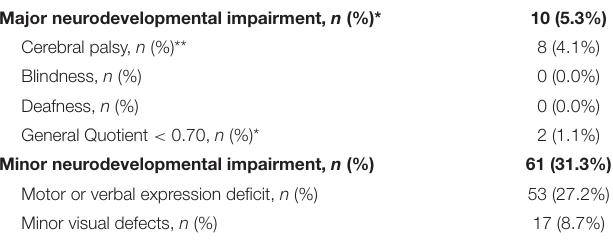
TABLE 4 | Evaluation of possible association between weight and HC z- scores at birth and major and minor neurodevelopmental impairment at 24 months of corrected age.